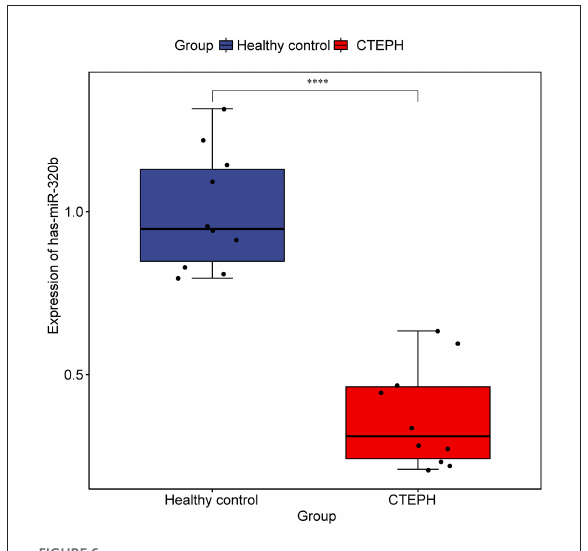
FIGURE6 Expression of hsa-miR-320b in samples from dataset GSE56914. The rank sum test was used to analyze the difference of hsa-miR-320b expression between healthy control group and CTEPH group. **** represents p < 0.0001. p < 0.05 was considered statistically